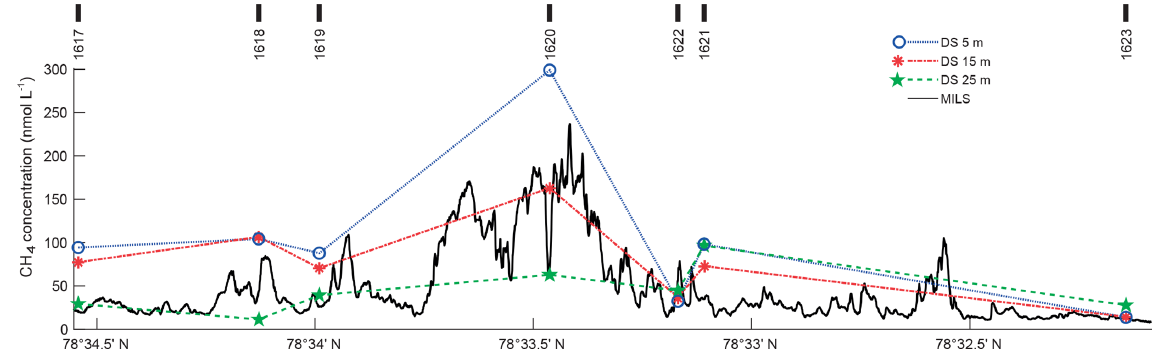
Figure 7. Underlying CH 4 concentration data for inventory calculations. Solid black line shows the continuous MILS profile ∼ 15ma.s.f. along line 3. DS concentrations at various depths are shown as blue circles, red asterisks, and green stars for 5, 15, and 25ma.s.f., respectively, and blue dotted, red dash-dotted, and green dashed lines represent the corresponding linear horizontal interpolations. CTD cast numbers are marked with thick black lines at the top of the graph. Table 1. Average concentrations (nmolL − 1 ) calculated with different methods at different altitudes as indicated in the first column (metres above the seafloor, ma.s.f.). 1 Average of the sparse discrete sampling from CTD casts 1617–1623. 2 Average of high-resolution (MILS) measurements from line 3. 3 Average of linearly interpolated concentrations based on discrete measurements (CTDs 1617–1623). 4 Average concentrations from the 2-D model, extracted from depths matching the MILS position along line 3. 5 Average concentrations within the box (4500m ( L ) × 50m ( W ) × 75m ( H )) based on the high-resolution measurements or interpolated concentrations along the box, vertical distribution based on the dissolution profile, and horizontal distribution across the width of the box based on the mean horizontal concentration gradient (Fig. S2). 6 Average of the 2-D model (best simulation) result from 0 to 75ma.s.f. and across the domain. 7 The control volume (CV) model yields a box value